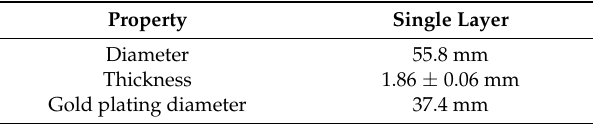
Table 2. Geometric properties of the single layer sample.